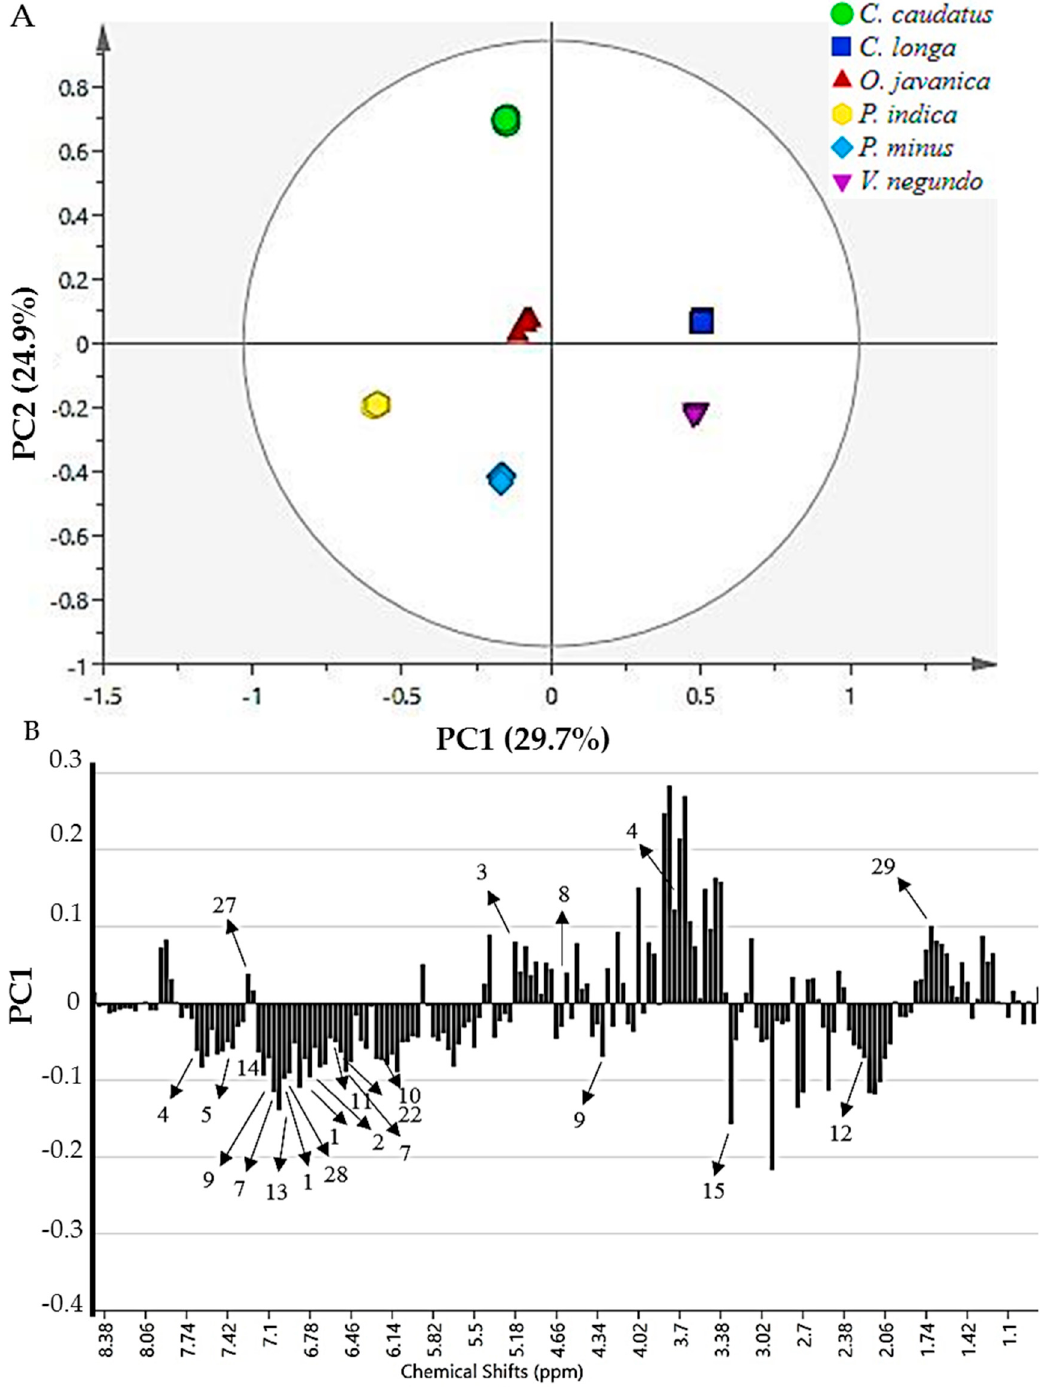
Figure 4. The principal component analysis (PCA) score plot ( A ) and the loading column plots ( B ) of the 1 H-NMR data representing all the selected herbs. The numbering of the signals refers the to the metabolites in Table 1.